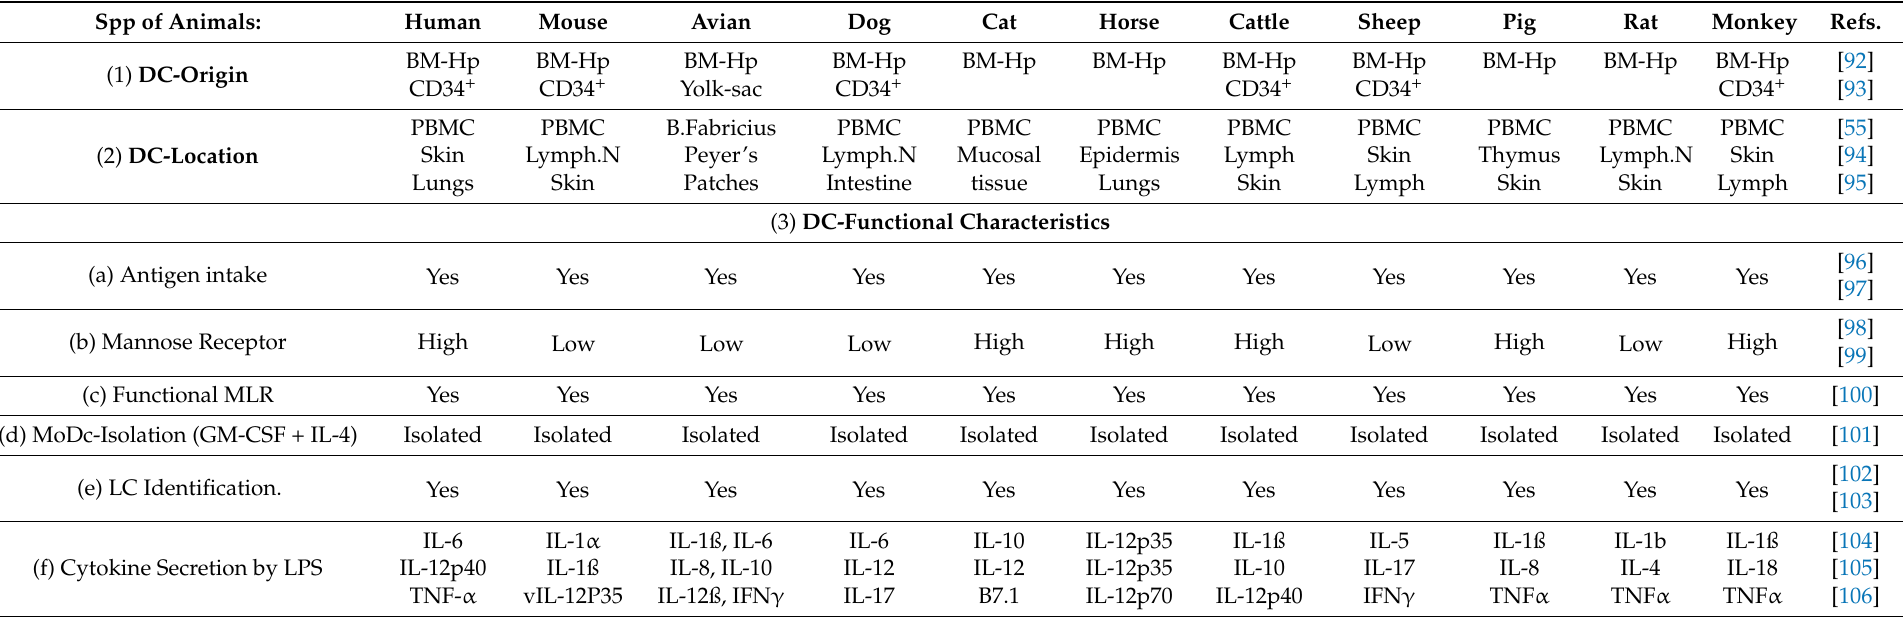
Table 1. Dendritic cell origin, location, and functional characteristics.